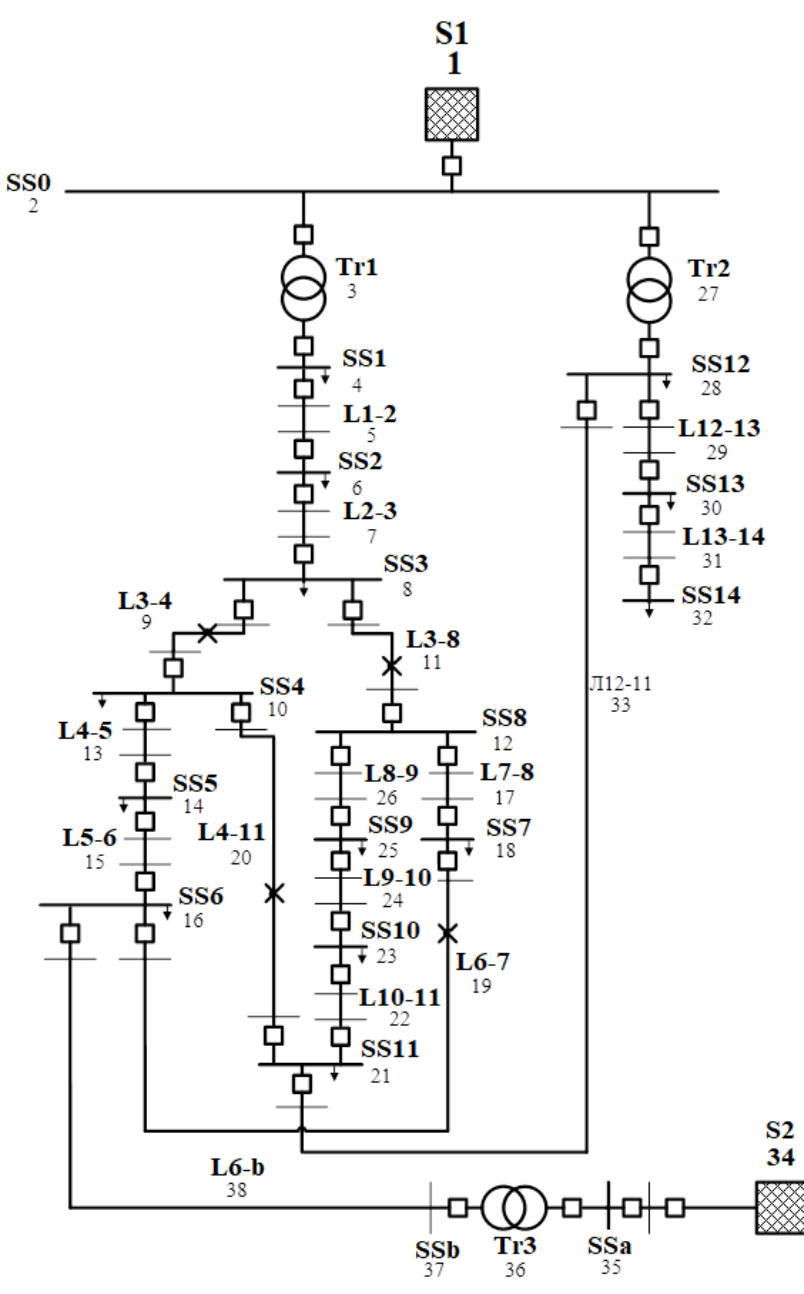
Figure 5. Structure 3 of the distribution network.